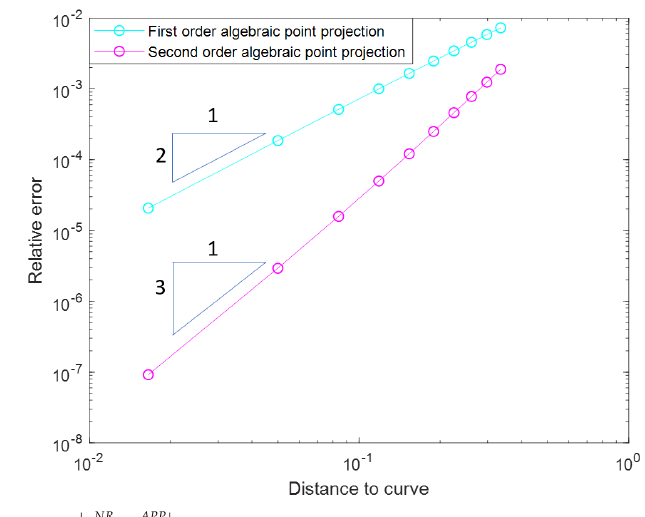
− u APP | | u NR f f vs. distance of test points d ( x ) , where u NR b − a